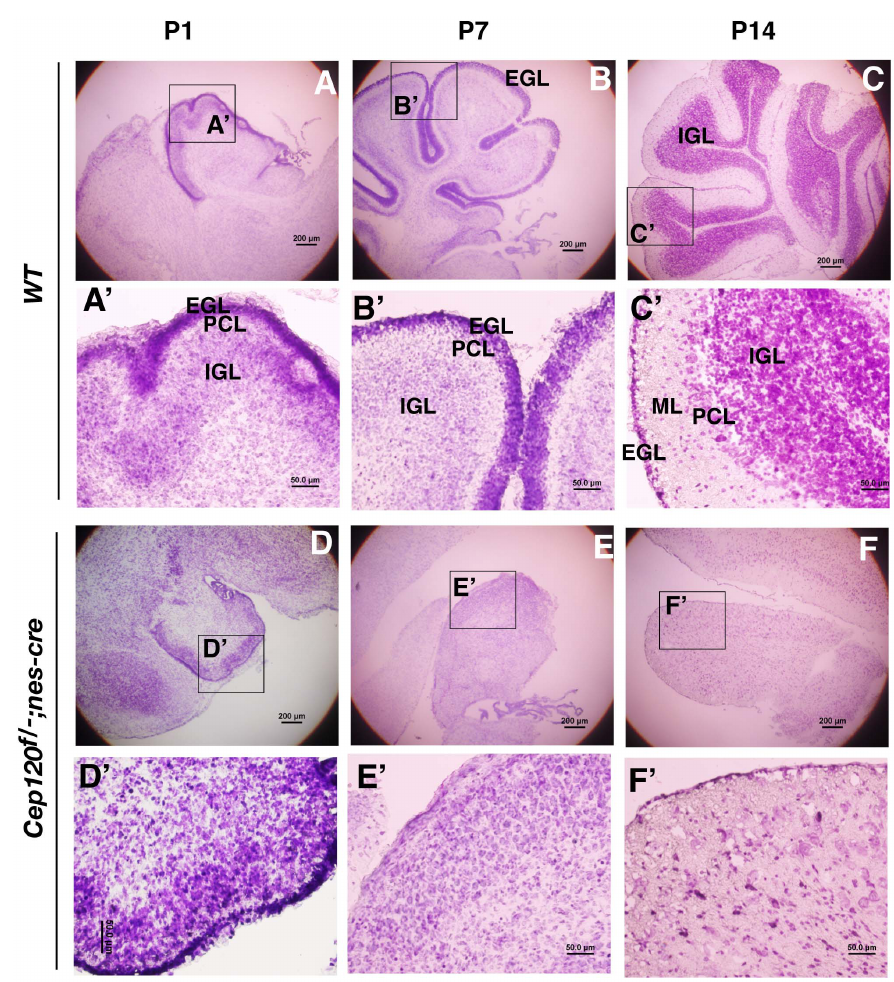
Figure 4. The Cep120 mutation results in cerebellar hypoplasia. Sagittal sections of P1, P7, and P14 wild type and Cep120 f/- ; nes-Cre mutant cerebellums were stained with cresyl violet. Framed areas are enlarged in the corresponding lower panels. EGL, external granule cell layer; PCL, Purkinje cell layer; ML, molecular layer; and IGL, inner granule layer.